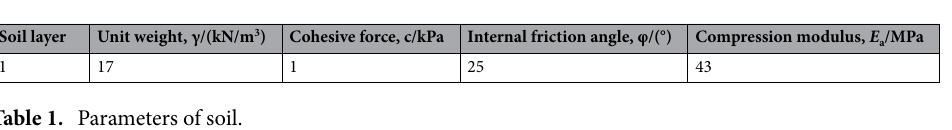
Figure 7. Finite element model in Midas/GTS.